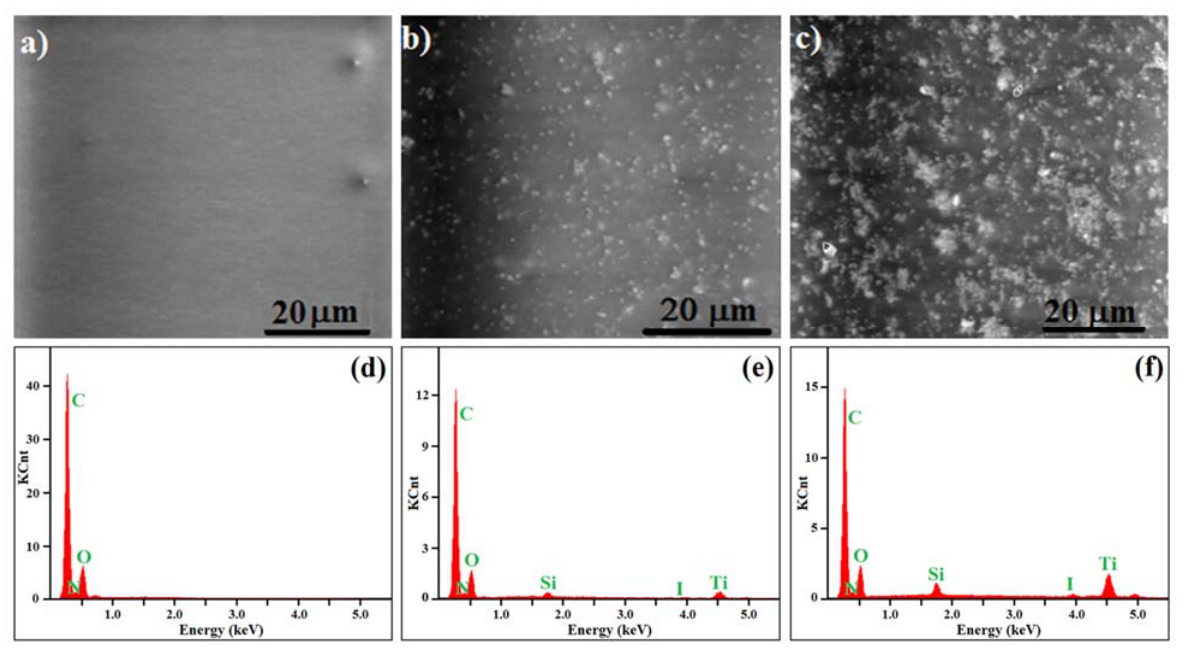
Figure 4. SEM microphotographs and the corresponding EDX measurements of the PU-2 polyurethane ( a , d ), PU-2-0.5 ( b , e ) and PU-2-1.0( c , f ) composites films.